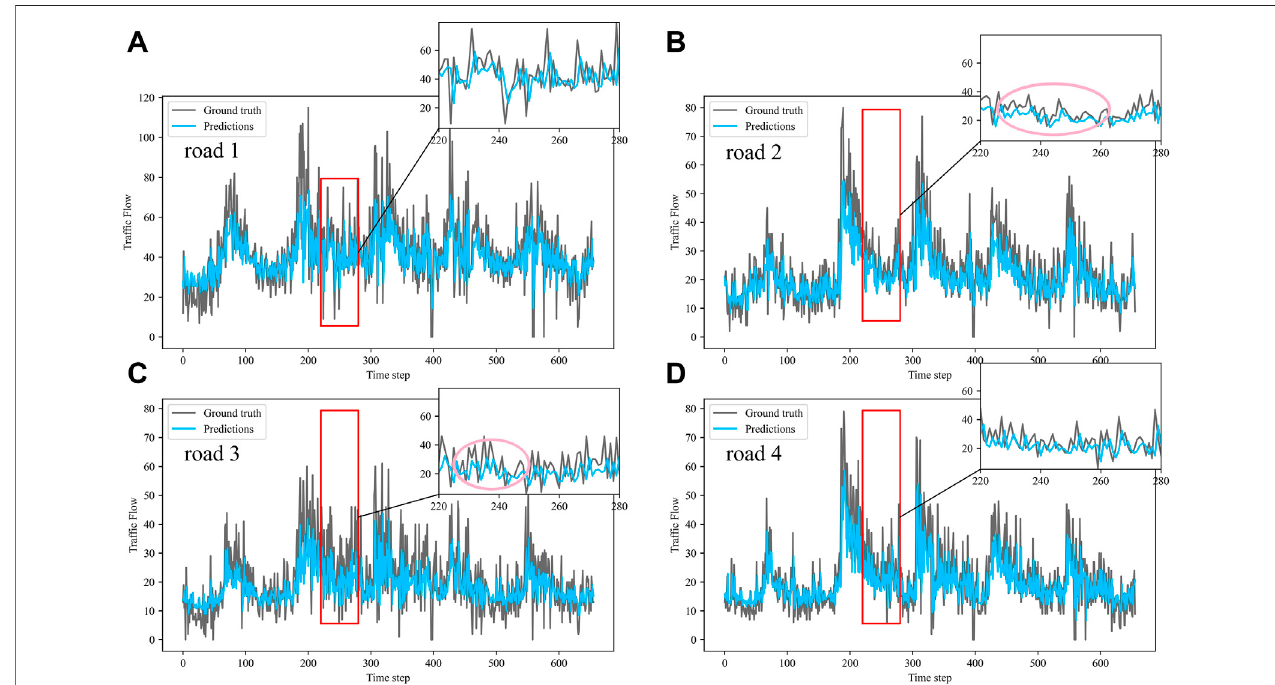
FIGURE8| VisualizationofIMgrumodelpredictionresultsonoff-peakdataset. (A) road1meansGudunRoad. (B) road2meansFengtanRoad. (C) road3means Yile Road. (D) road 4 means Jingzhou Road.